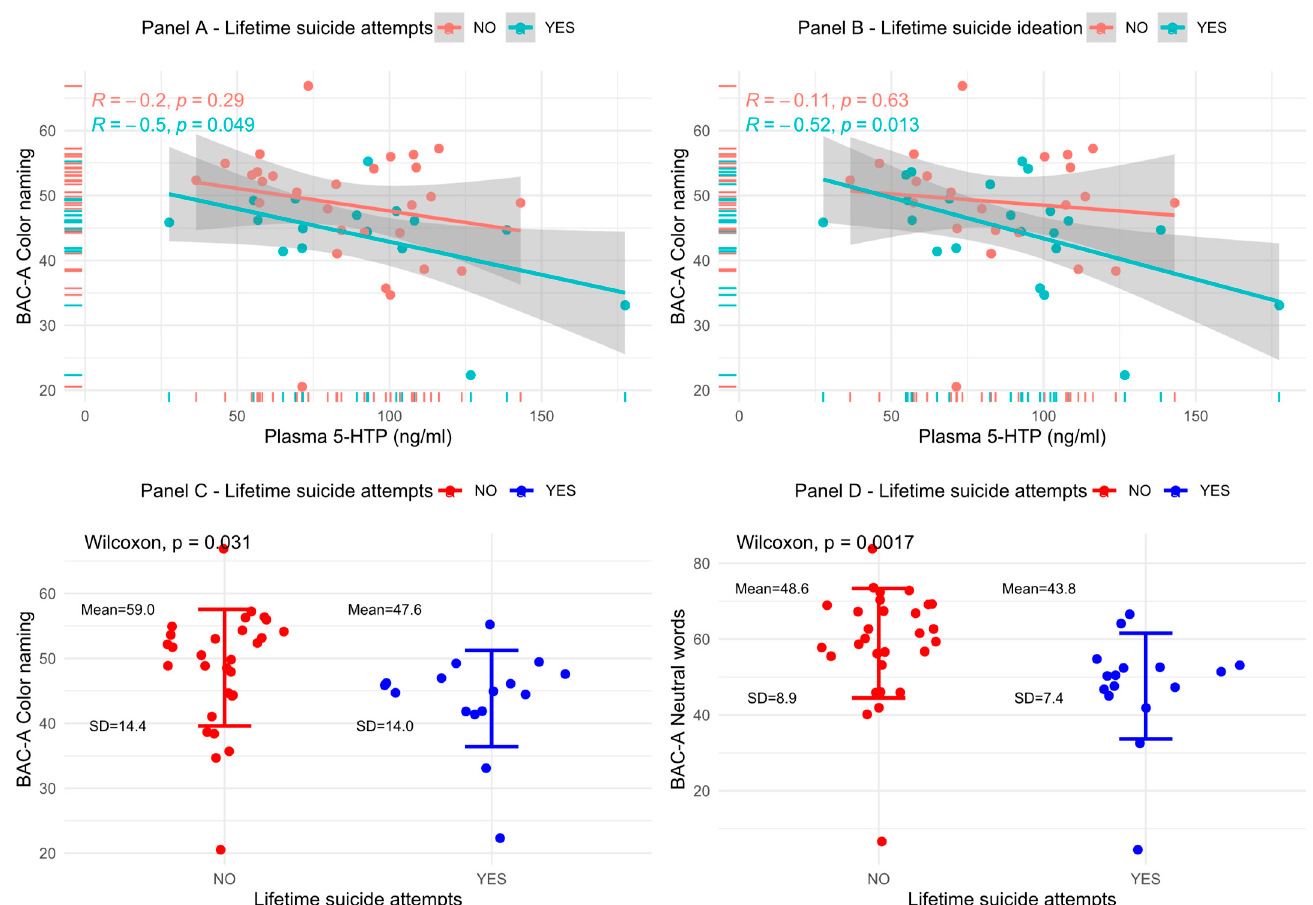
Figure 3. Relationship between cognitive measures, lifetime suicide behavior and plasma 5-HTP levels.